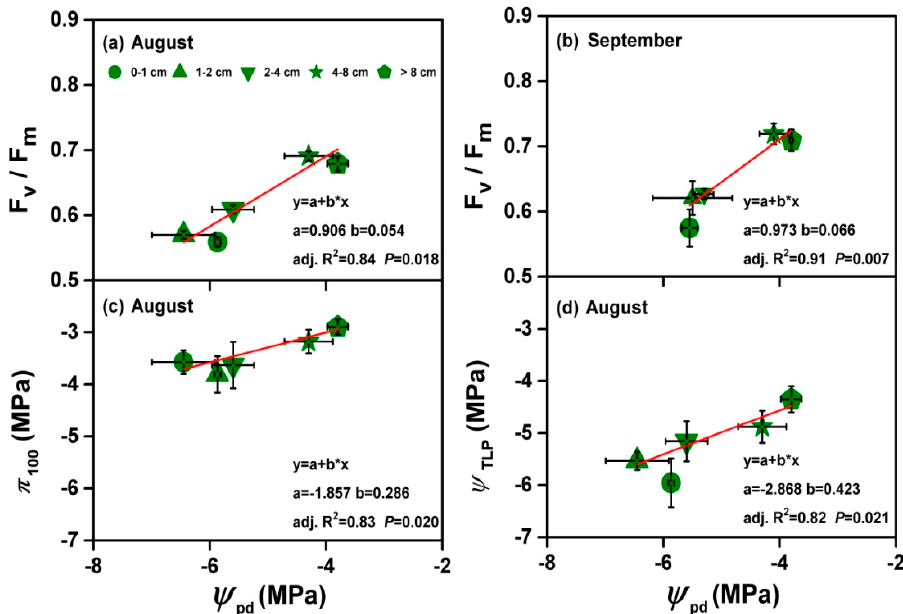
Figure 5. The maximum photochemical efficiency of photosystem II (Fv/Fm, a , b ), osmotic potential at full turgor ( π 100 , c ) and osmotic potential at turgor lost point ( Ψ TLP , d ) in relation to predawn leaf water potential ( Ψ pd ). Data are mean ± 1 SE ( n = 5).